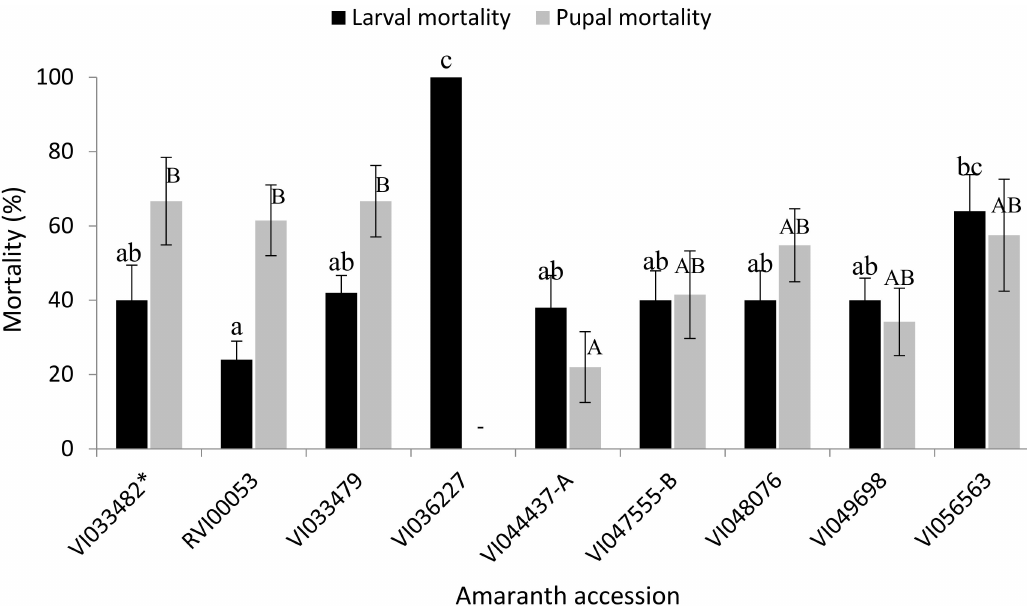
Figure 2. Total larval and pupal mortalities (mean ± SE) of S. recurvalis recorded on selected accessions of amaranth. (Means of total larval (pupal) mortality with the same lower (upper) case letters are not significantly different at p < 0.05, (Tukey’s test)). * Susceptible accession.